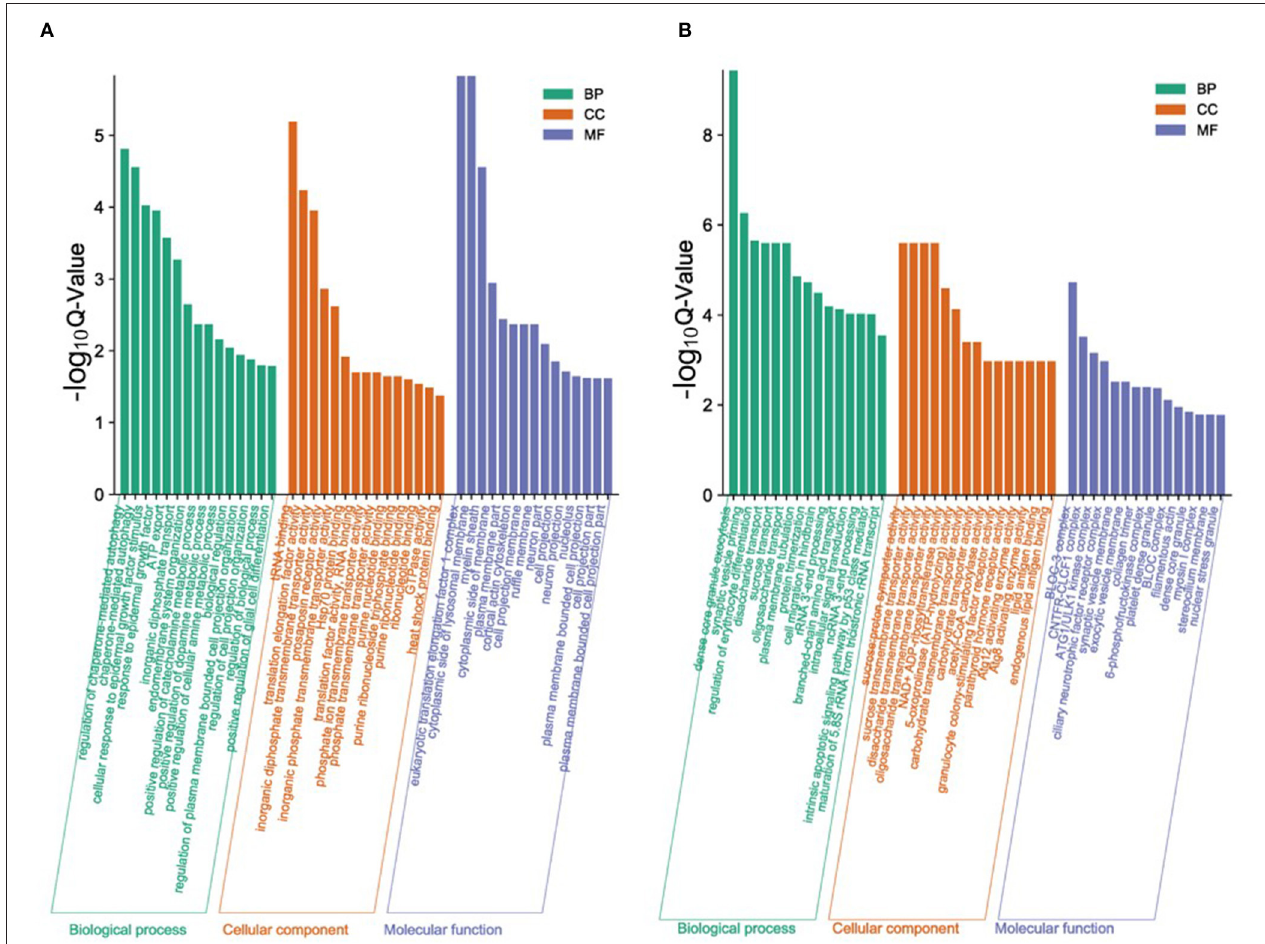
FIGURE 4 | The top 15 enriched GO terms for the identified DEGs and target genes of DEMs in FP-HY vs. FP-LY. Q-Value < 0.05 was used as a threshold to select significant GO terms. The abscissa and ordinate represent the GO terms and the -log 10 Q-Value of enriched genes, respectively. GO, Gene Ontology; BP, biology process. (A) GO enrichment terms for DEGs in FP-HY vs. FP-LY. (B) GO enrichment terms for target genes of DEMs in FP-HY vs.